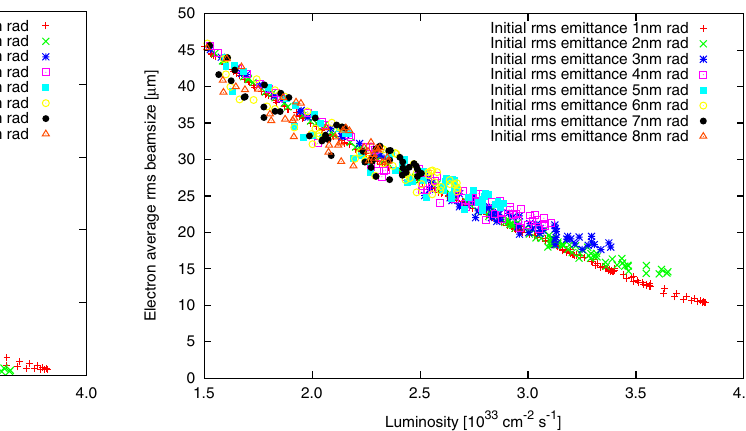
FIG. 13. (Color) Average electron beam size in IR as a function of luminosity.